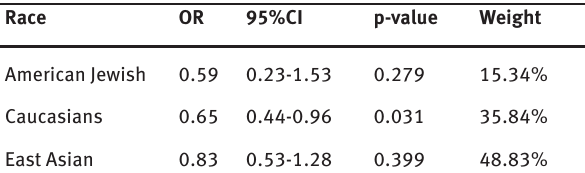
Table 2: Subgroup analysis of MTHFR C677T polymorphism and non- traumatic osteonecrosis of the femoral head(CC vs CT+TT).